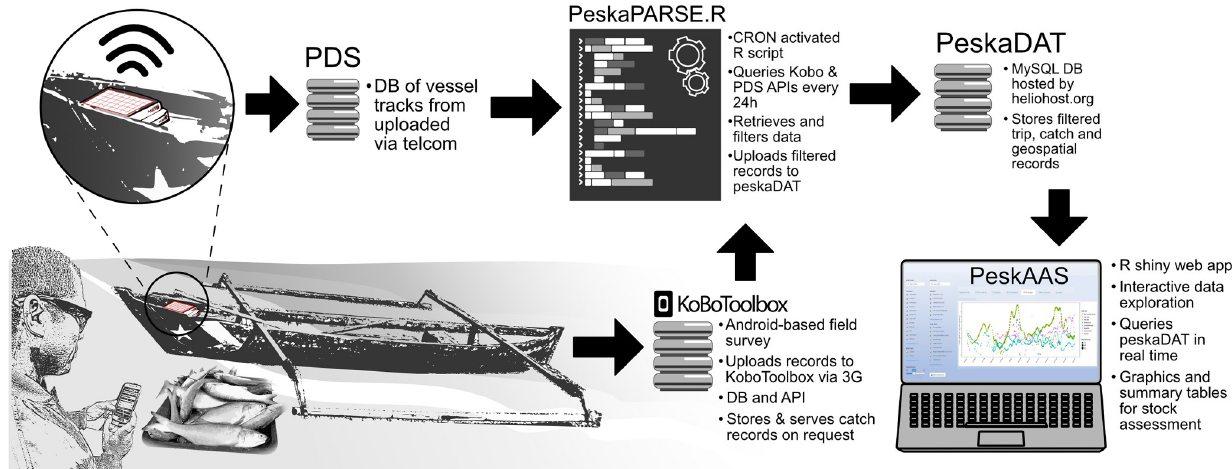
Fig 2. A diagrammatic representation of the PeskAAS application. From bottom left, the catch from a fishing vessel is entered into a KoboCollect survey form on a smartphone. These data are uploaded to the KoboToolbox database (DB). The PesksPARSE.R script pulls these data along with the movement track of the fishing trip from PDS via an application-programming interface (API) every 24 hours. These data are then checked and filtered, and uploaded to the PeskaDAT database. The PeskAAS Shiny web app queries PeskaDAT and displays near-real-time graphics and analytics.